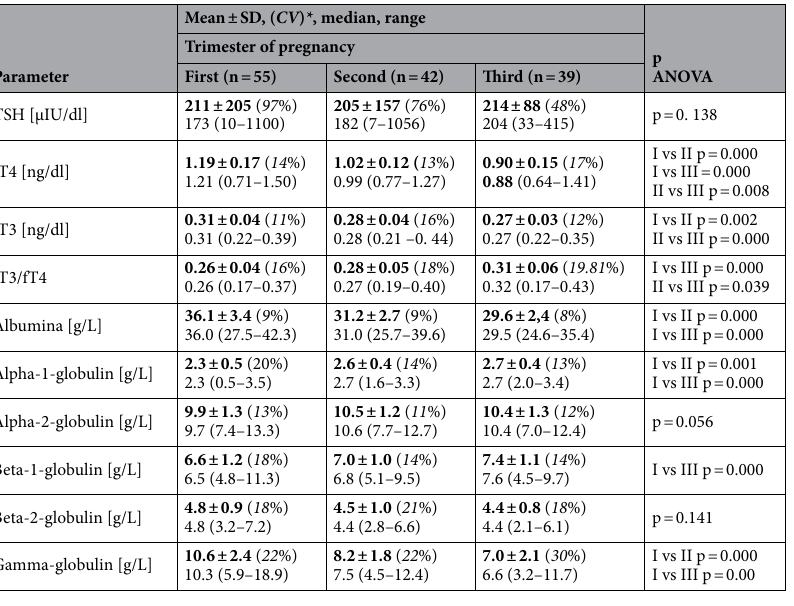
Table 1. Changes in the serum concentrations of thyroid hormones and six major protein fractions across normal